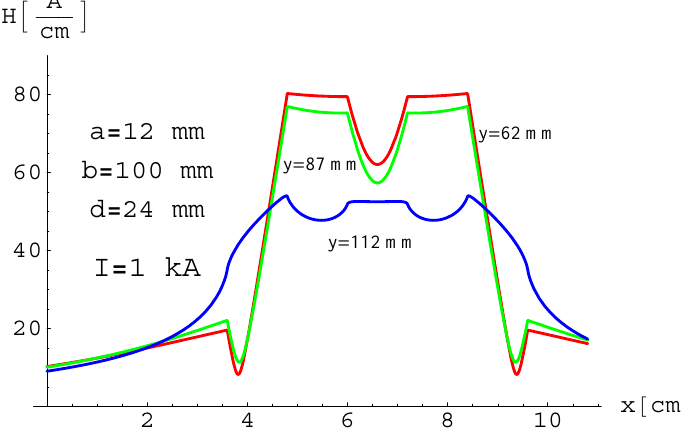
Figure 10. The distribution of magnetic field intensity along the line x = const of an unshielded busbar system with current symmetry. Figure 11. Spatial distribution of magnetic field intensity of an unshielded busbar system with current symmetry. If skin and proximity effects are taken into account, then in order to determine the magnetic field intensity distribution of an unshielded and shielded busbar, the integral equation method (IEM) should be used. The relevant graphs are shown in Figures 12–17.